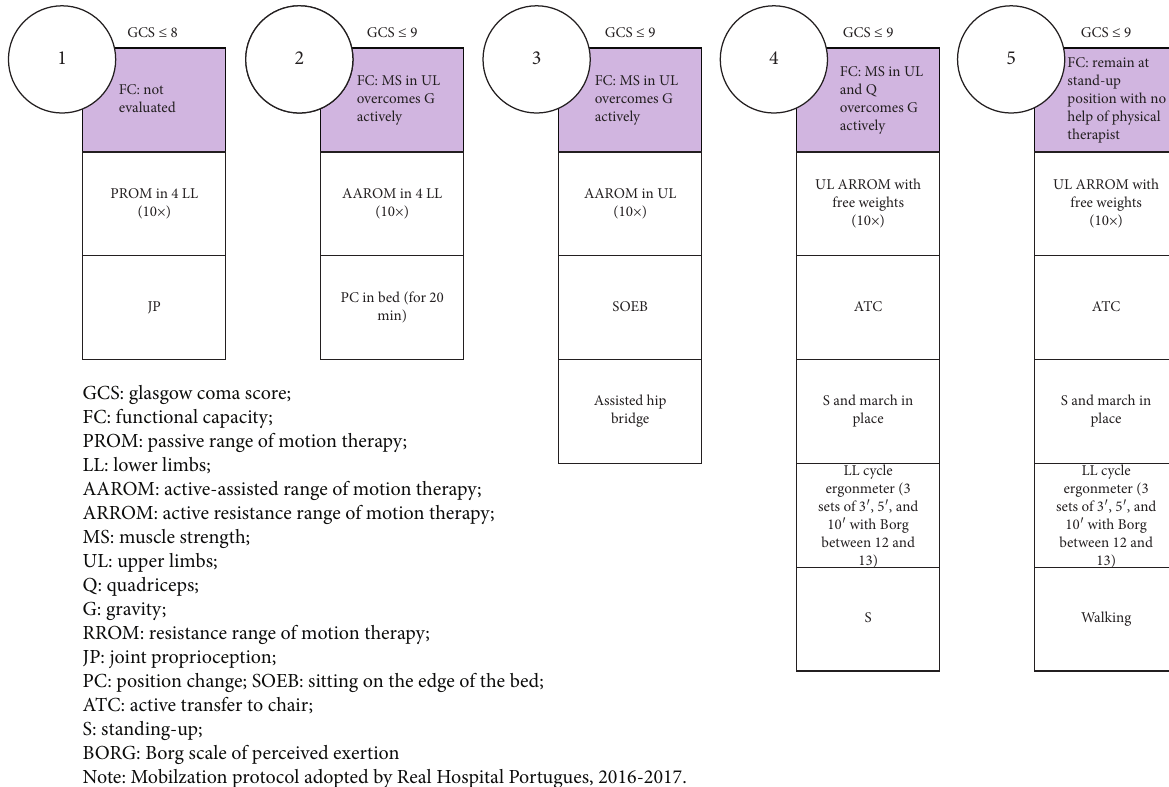
Figure 1: Early mobilization